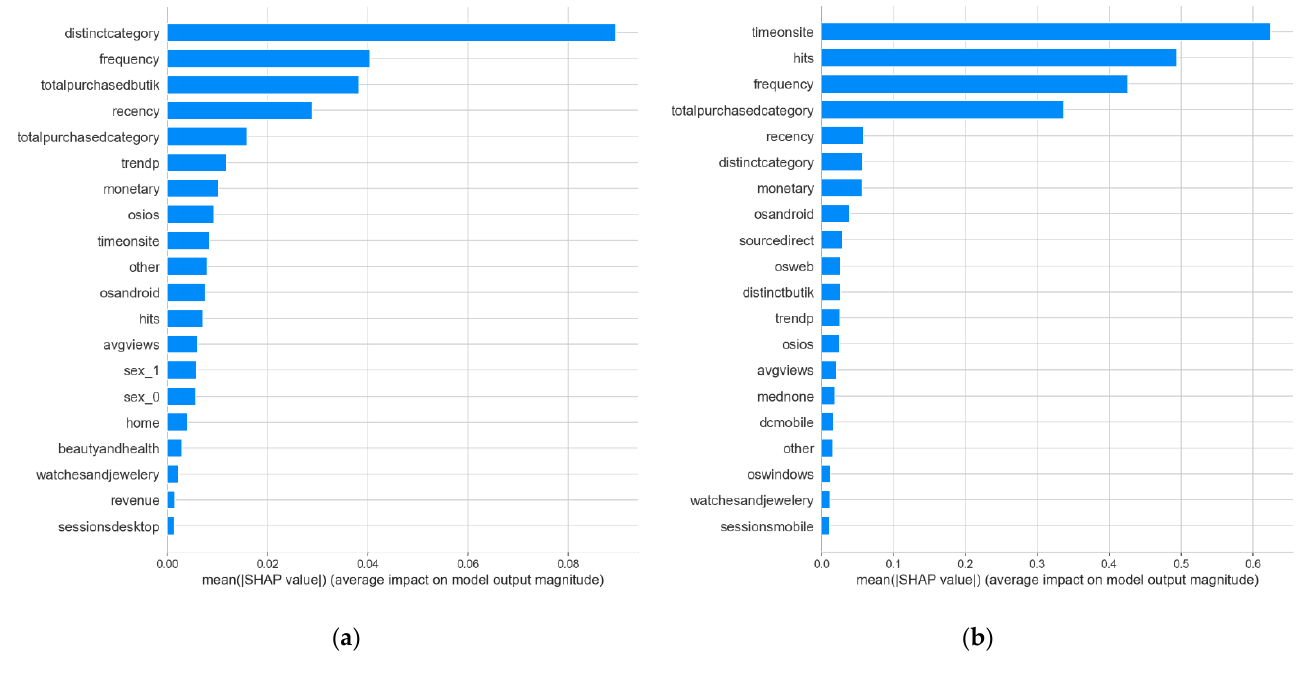
Figure A1. Feature importance levels defined by average SHAP values for Distinct Product Category